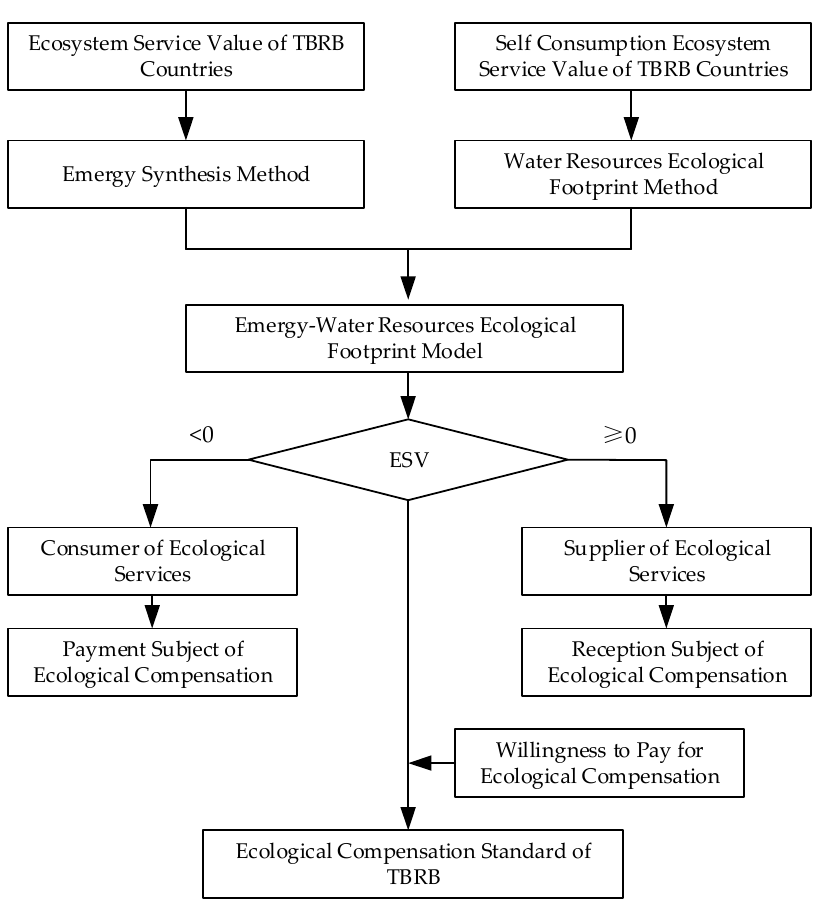
Figure 1. Logical structure of ecological compensation standard determination in trans-boundary river basins.